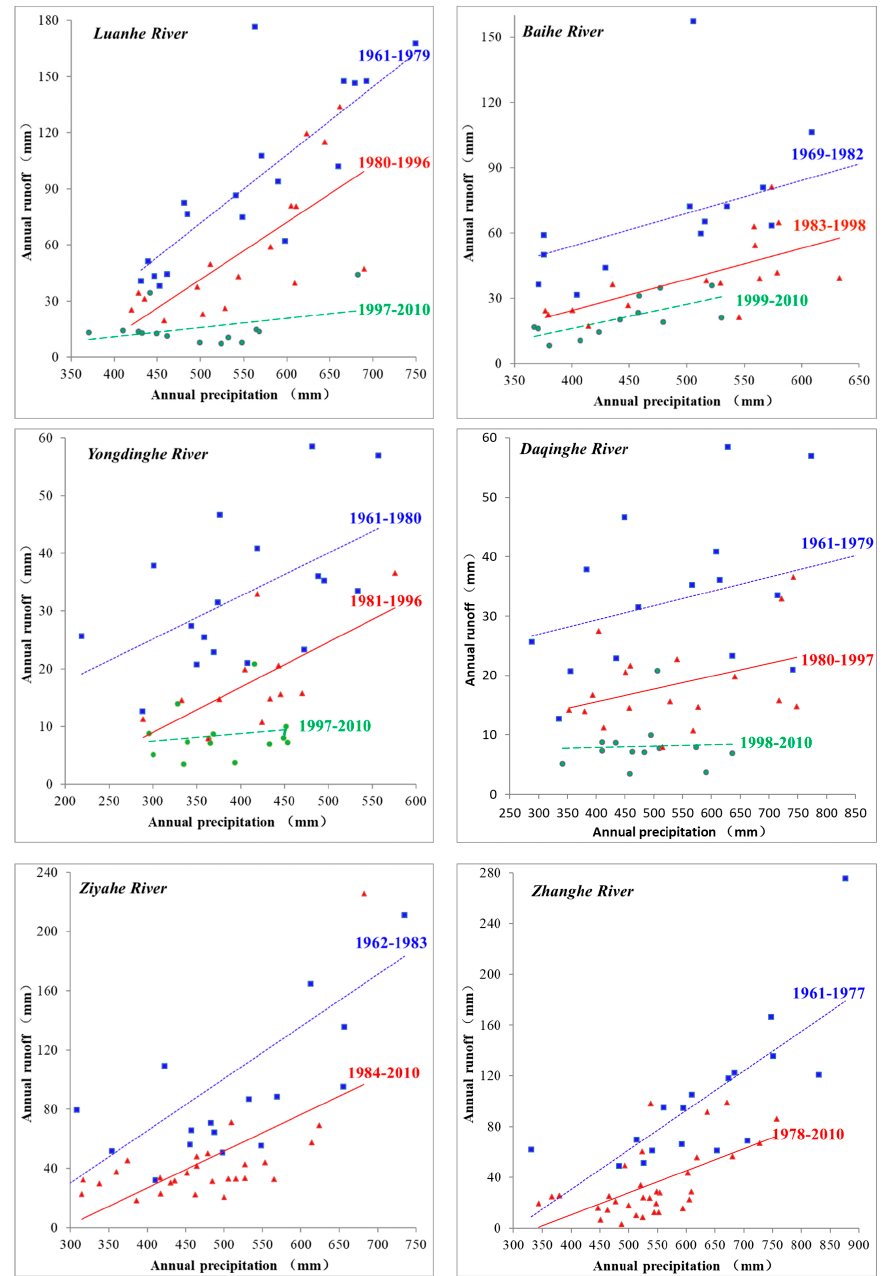
Figure 6. Relationship between precipitation and runoff in the upstream areas of the Luan River, Yongding River, Ziya River, and Zhang River sub-basins. Yongding River, Ziya River, and Zhang River